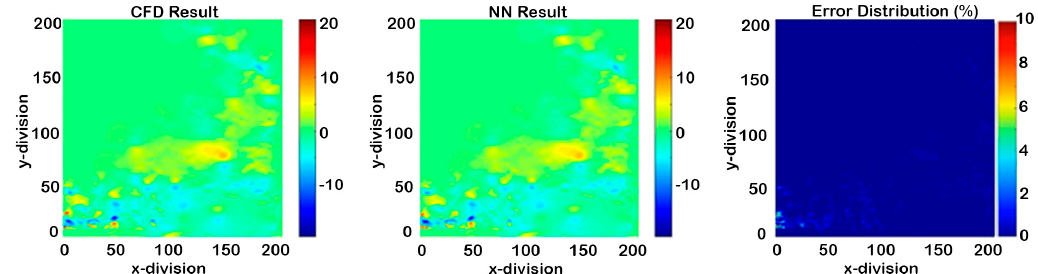
Figure 24. Cascading results of Model Ⅱ for X -direction velocity (seven time-steps after deployment).